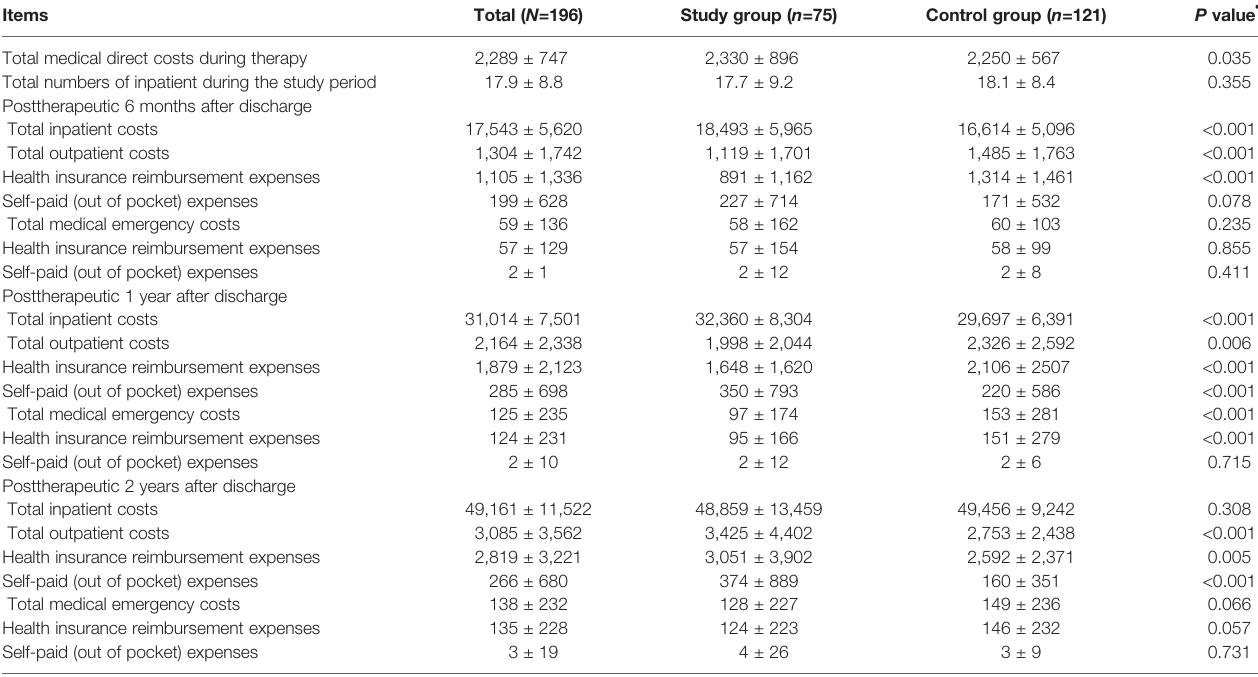
cancer at different time point. ¶ P-values calculated by Student ’ s t-test.